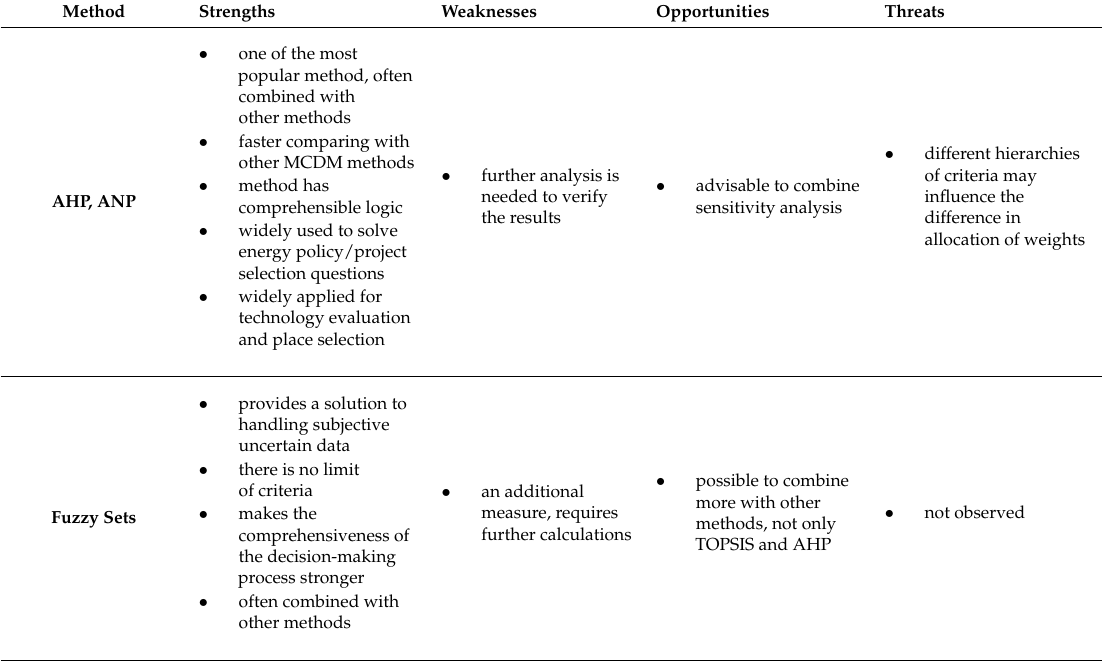
The SWOT analysis of the MCDM approaches in dealing with sustainable energy development